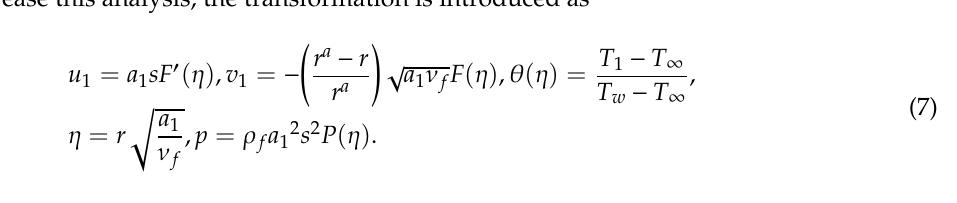
Figure 1. (a-c): Physical diagram of the problem. 2